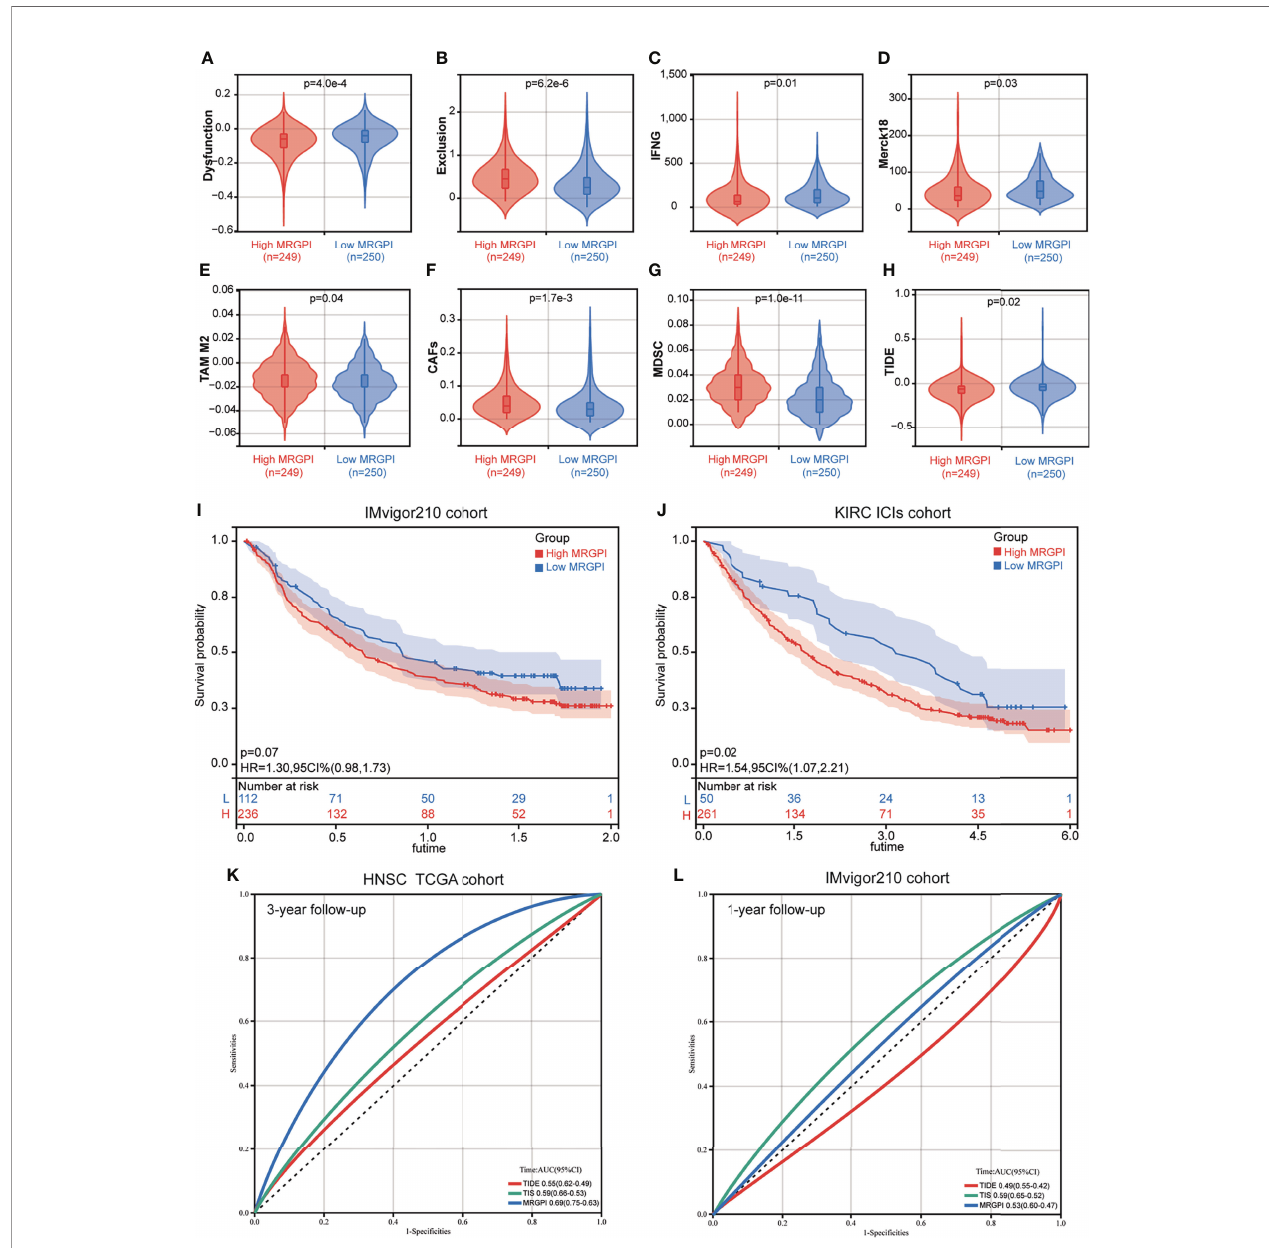
FIGURE 5 | The prognostic signi fi cance of the MRGPI in patients with immune checkpoint inhibitor therapy. (A – H) T-cell dysfunction score, T-cell exclusion score, IFNG, Merck18, M2-TAMs, CAFs, MDSCs, and TIDE score in the different MRGPI subgroups. The scores between the two MRGPI subgroups were compared through the Wilcoxon test. (I) Kaplan – Meier analysis of the MRGPI subgroups in the IMvigor210 cohort. (J) Kaplan – Meier analysis of the MRGPI subgroups in the KIRC ICI cohort. (K) ROC analysis of the MRGPI, TIDE, and TIS on overall survival at 3-year follow-up in TCGA cohort. (L) ROC analysis of the MRGPI, TIDE, and TIS on overall survival at 1-year follow-up in